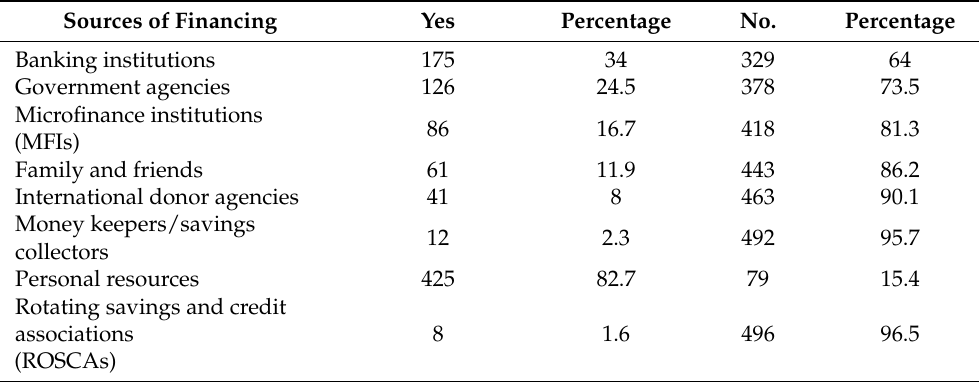
Table 1. Sources of